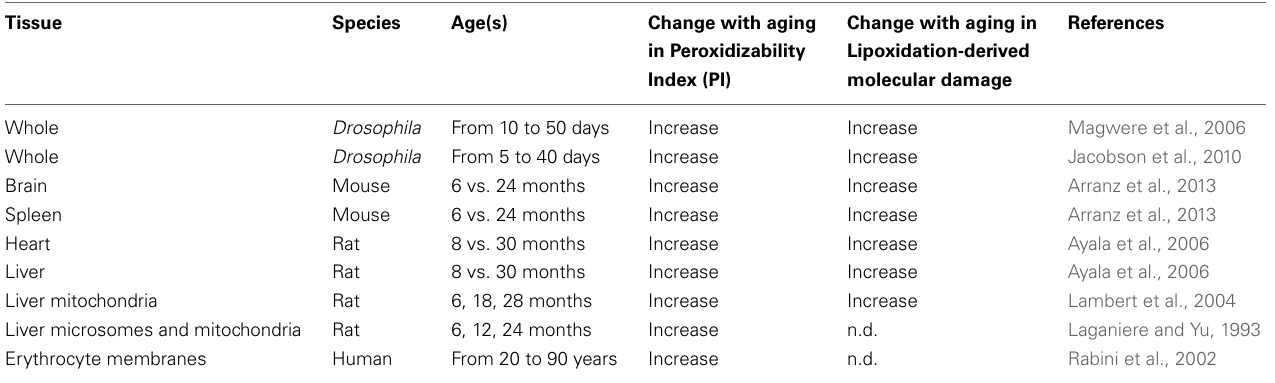
Table 1 | Effect of aging on membrane peroxidizability index and lipoxidation-derived molecular damage in tissues from different species.